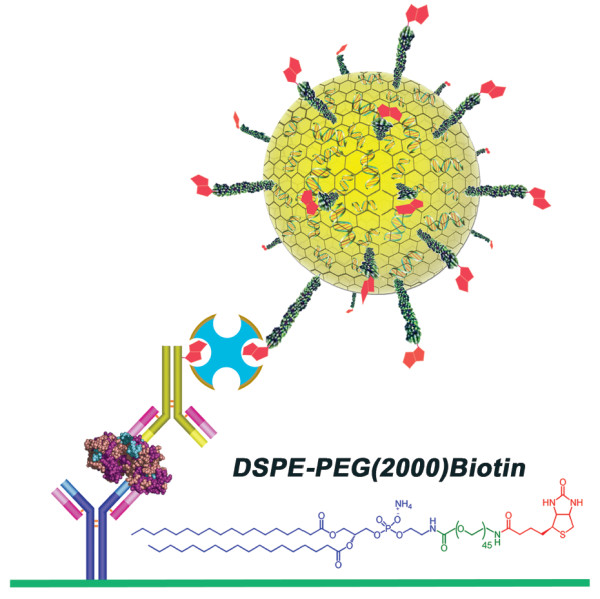
Drawing depicting the ILPCR assay format. The antigen (purple, brown, and blue) is bound by an immobilized capture antibody (blue and purple) and a biotinylated secondary antibody (green and purple). The liposome detection reagent (yellow) is coupled to the biotinylated secondary antibody through a NeutrAvidin bridge (aqua and brown). The biotin-labeled PEG phospholipid conjugates are pictured as PEG polymers (dark green) terminating in biotin molecules (red) with the phospholipid component (not visible) embedded in the outermost bilayer leaflet of the liposome. Encapsulated DNA reporters (green with red bars) can be seen inside the liposome. Shown at the bottom right is the biotin-labeled PEG phospholipid conjugate used to prepare the detection liposomes: 1,2-distearoyl-sn-glycero-3-phosphoethanolamine-N-[biotinyl (polyethylene glycol) 2000] ammonium salt. The phospholipid moiety is depicted in blue, the PEG (2000) polymer moiety in green, and the biotin moiety in red.